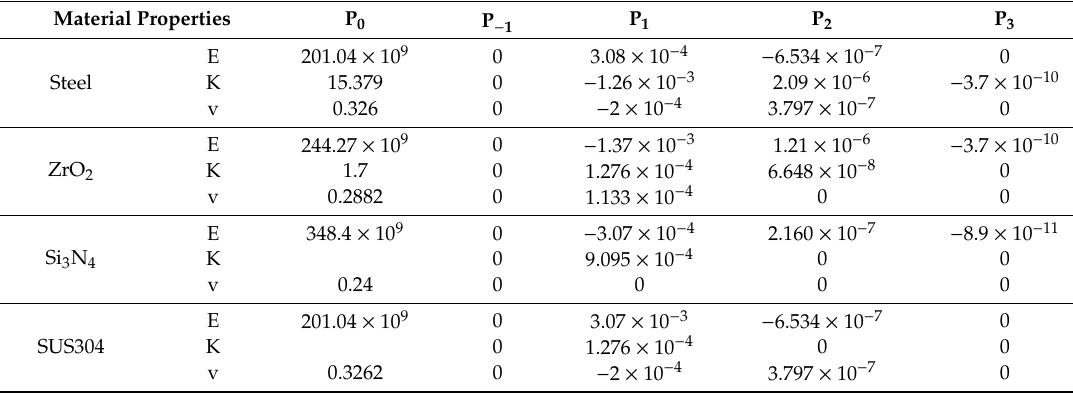
Figure 1. Distribution of metal and ceramic phases along the radial direction of a functionally graded (FG) shaft. Table 1. Thermal coe ffi cients of the constituent materials of functionally graded materials